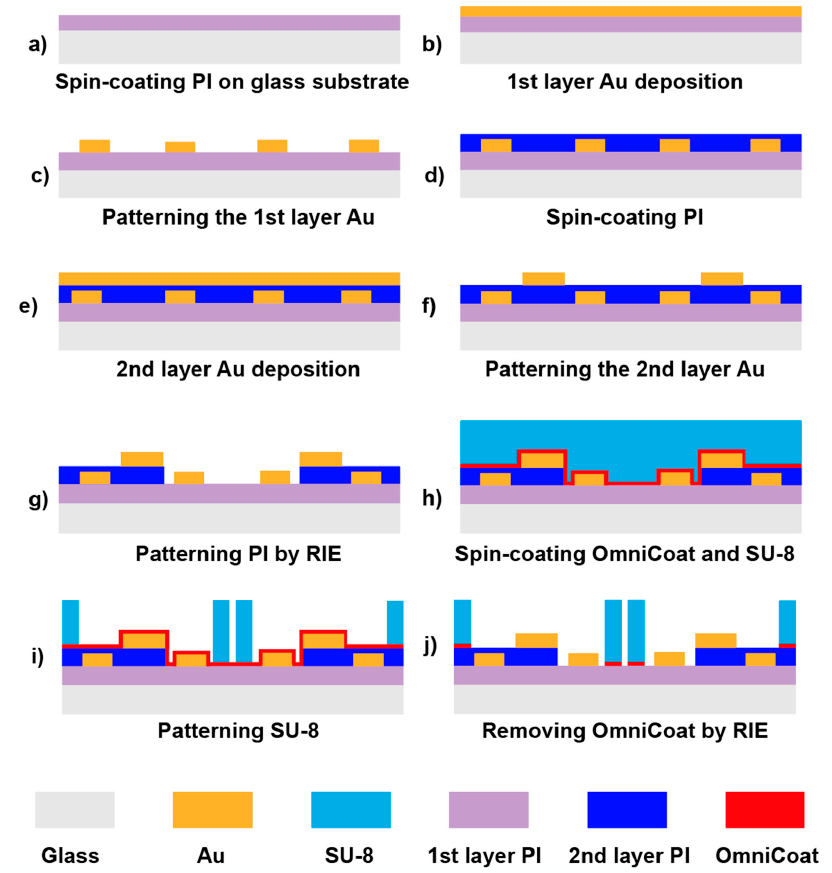
Figure 2. Step-by-step fabrication procedure of proposed LOC device.